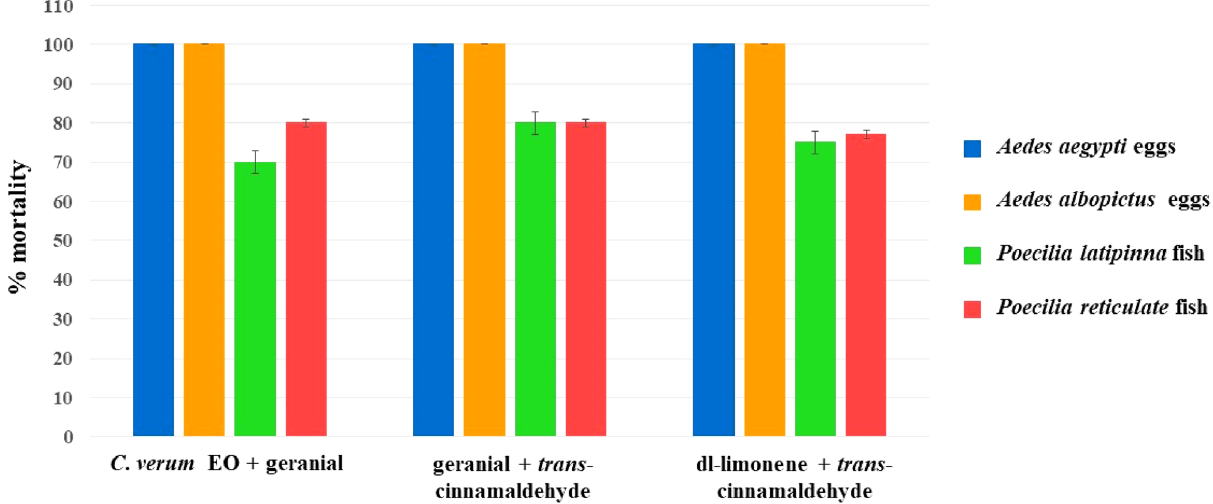
Figure 3. Mortality rates of the combined formulations against the eggs of Aedes aegypti and Aedes albopictus , compared to those against non-target predators of mosquitoes, Poecilia latipinna and Poecilia reticulate